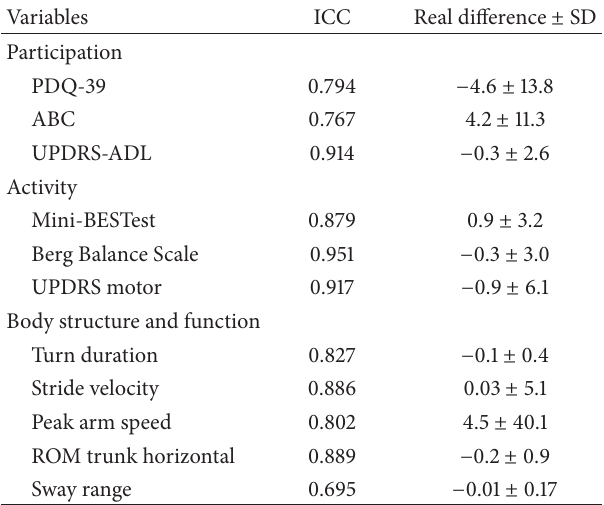
Table 2: Baseline stability of outcome